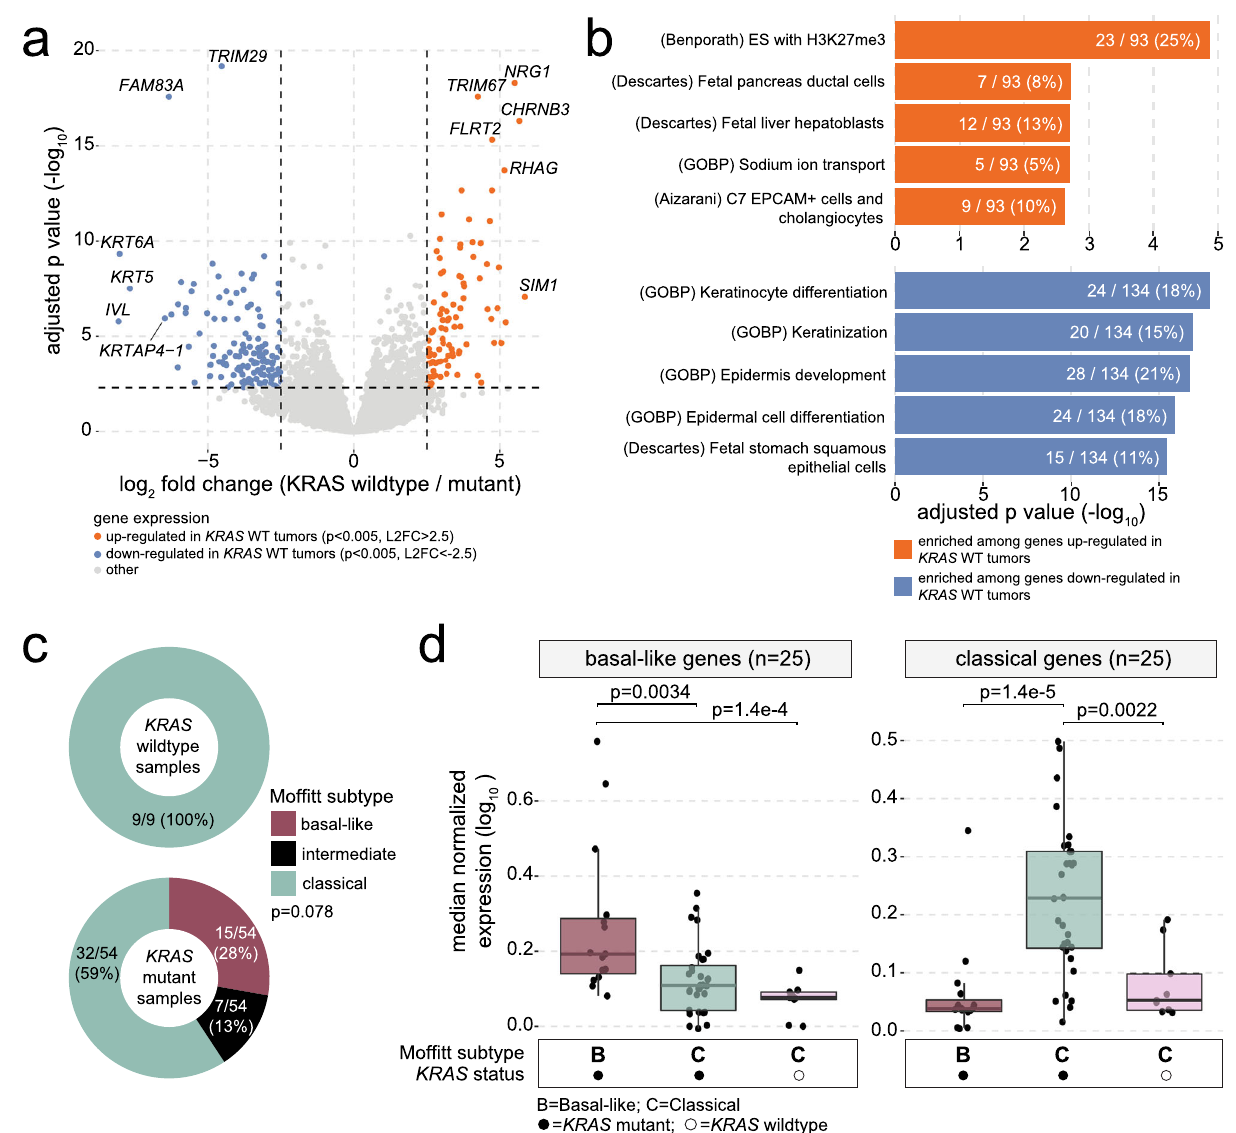
cholangiocytes. c Donut plots showing the distribution of Mof fi tt subtype calls across KRAS wildtype (top) and mutant (bottom) groups. Two-tailed Fisher ’ s exact test p value shown. d Boxplotscomparingmedian mRNA expression levels of Mof fi tt basal-like (left) and classical (right) genes across KRAS wildtype and mutantgroups,strati fi edbyMof fi ttsubtype.Lefttoright: KRAS mutantbasal-like samples ( n =15), KRAS mutant classical samples ( n =32), KRAS wildtype classical samples ( n =9). Box plots indicate median (central line), 25 – 75% IQR (bounds of box), and whiskers extend from box bounds to the largest value no further than 1.5timestheIQR.Two-tailedWilcoxonmeanrank-sum p valuesareshown.Source data are provided as a Source Data fi